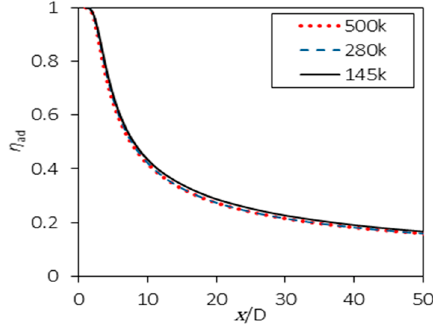
Figure 3. Mesh independence study with three different mesh sizes.